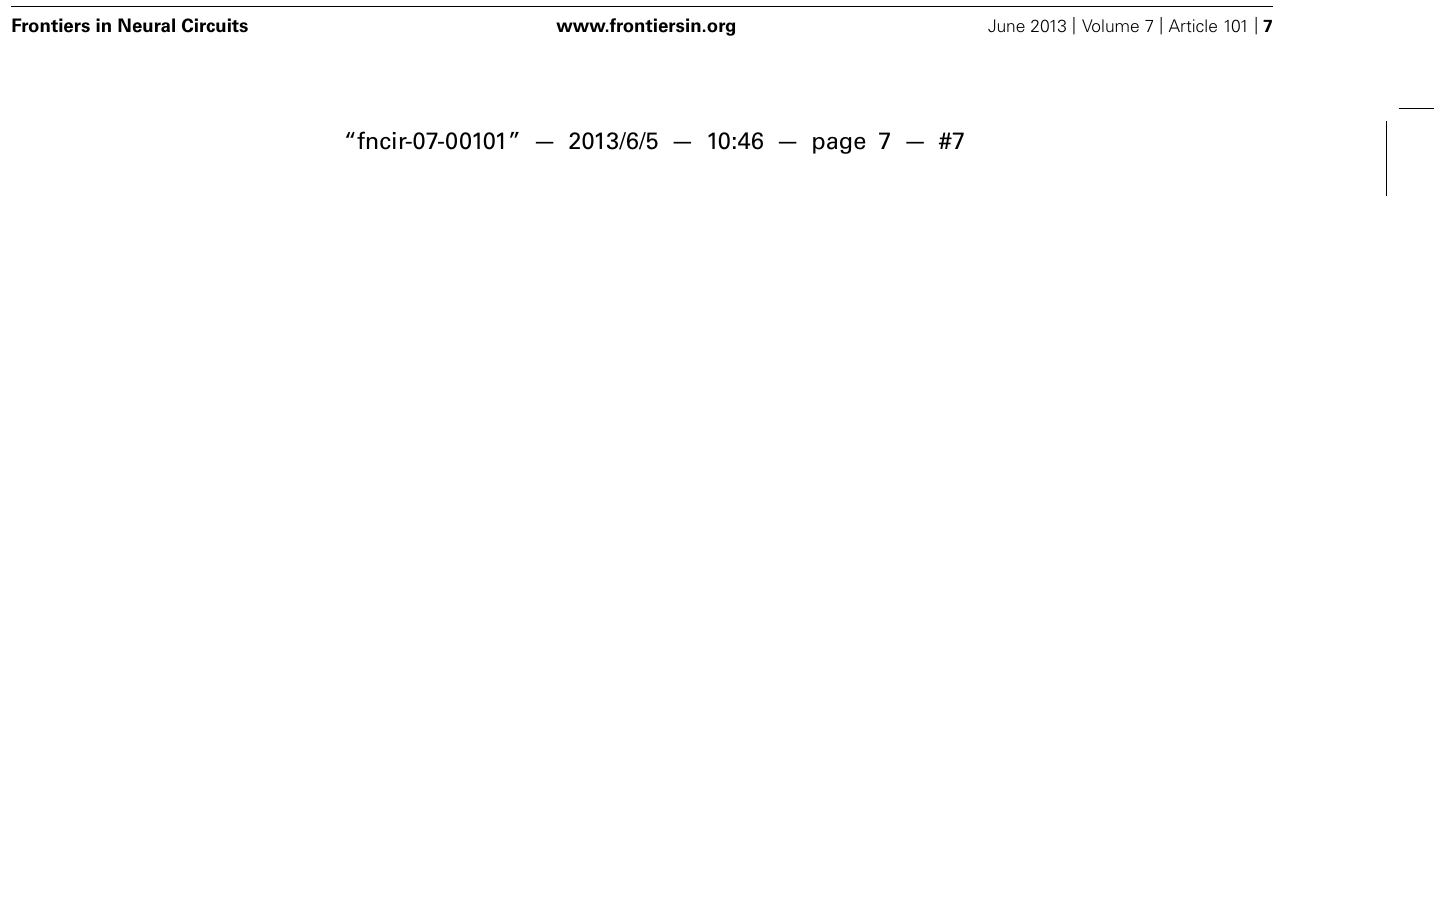
layer with a threshold-linear gain function (right). Colors in the contour plot represent neural firing rates from low to high. (B) Iso-responses contours (right) of a sensory neuron which non-linearly integrates stimulus variables x 1 , x 2 ≥ 0 with a threshold-quadratic gain function